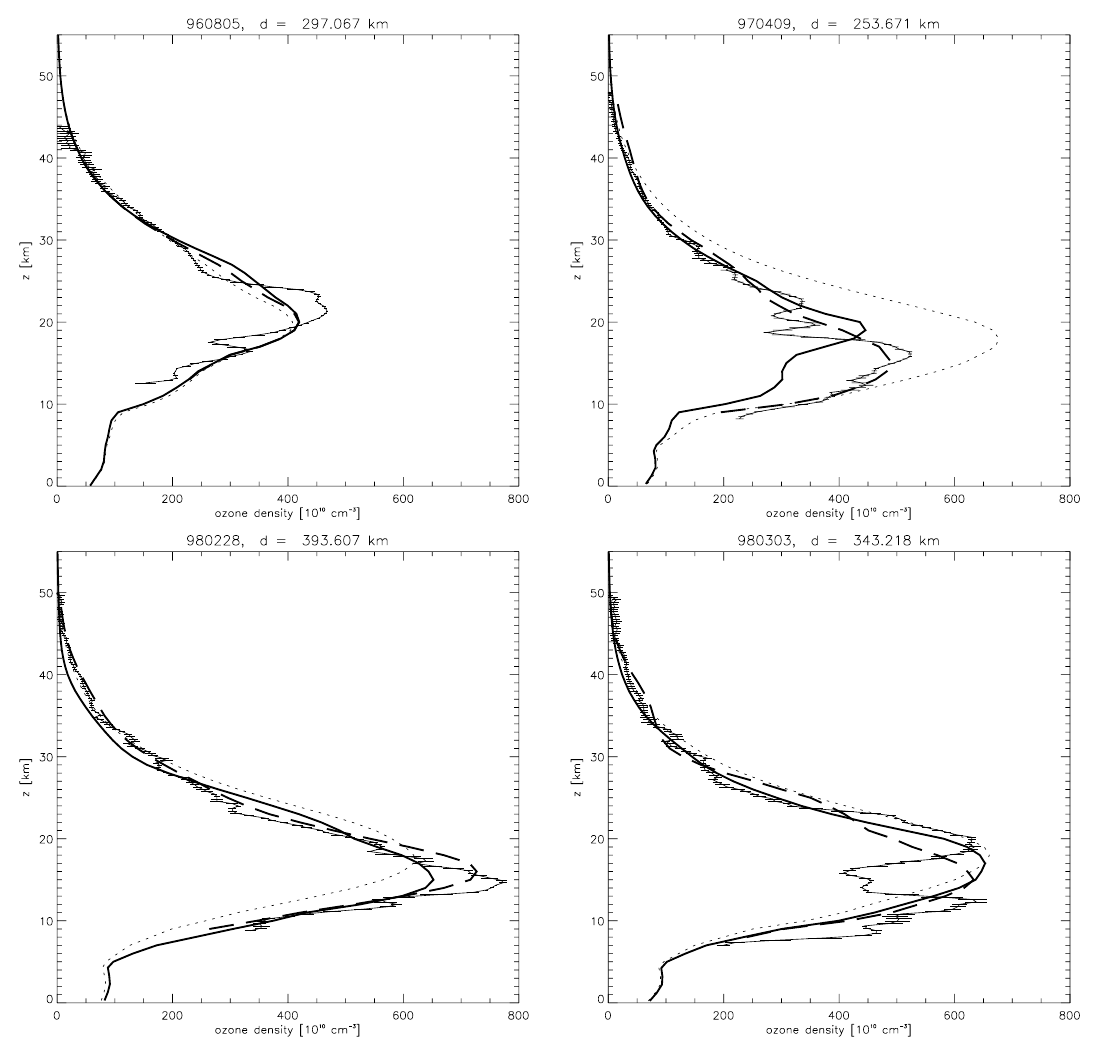
Fig. 2. Single ozone profile comparisons between ALOMAR ozone lidar and GOME: 5 August 1996 (upper left), 9 April 1997 (upper right), 28 February 1998 (lower left), 3 March 1998 (lower right). Thin solid line with error bars: full resolution lidar profile; dashed line: convolved lidar profile; bold solid line: GOME FURM profile; dotted line: a priori profile used in FURM. Value d in plot titles: distance between lidar site and GOME pixel